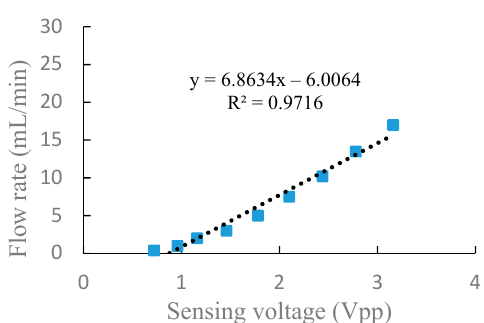
Figure 9. The relationship between flow rate and sensing voltage at 100 Hz in serial connection.